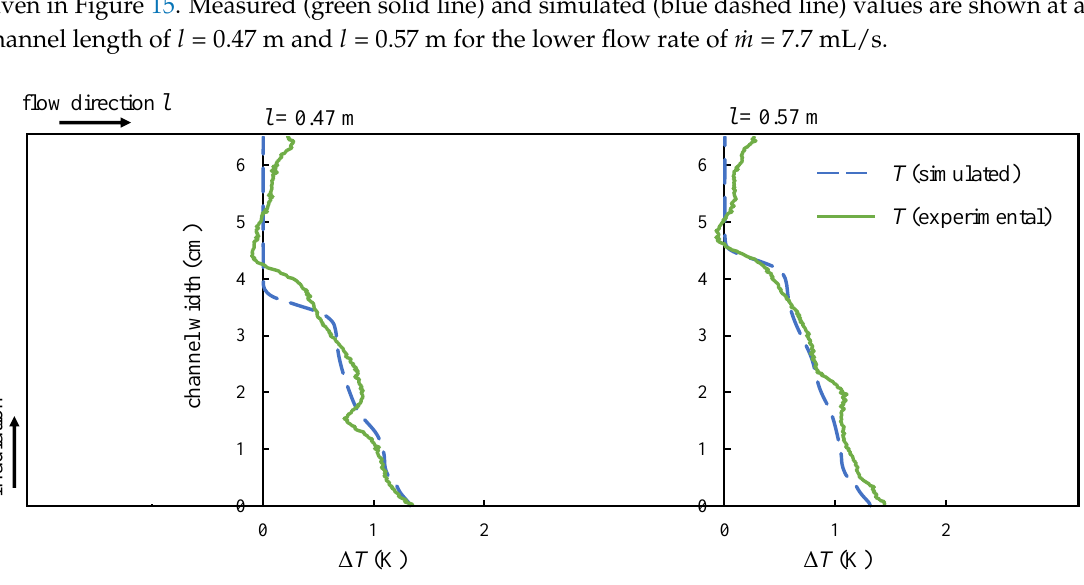
Figure 15. The simulated temperature distribution caused by absorbed radiation matches the experimental